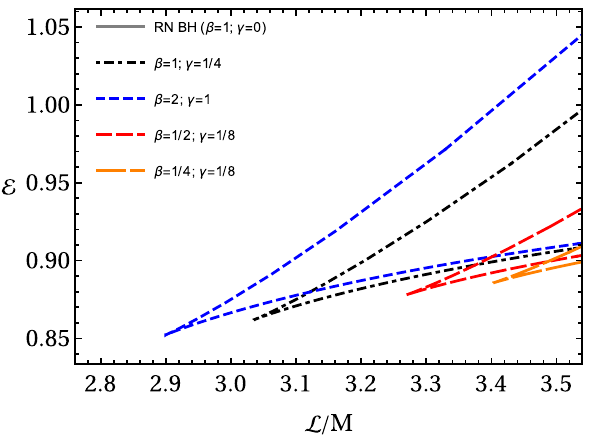
Fig. 5 The dependence of specific angular momentum of the test par- ticles around the BH from its energy at circular orbits. Here the BH charge is taken as Q = M